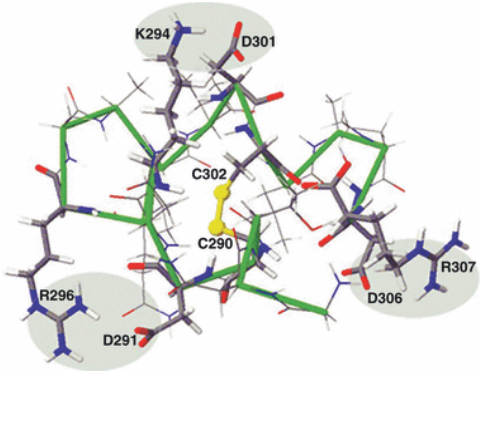
Figure 12. Molecular model of the longest extracellular loop formed by residues 288–307 of the C -terminal domain of OmpA [46]. Red: positive residues. Blue: negative residues. Yellow: Cys residues. The backbone is traced in green. Salt bridges are shown in gray